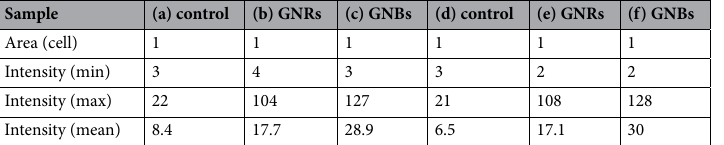
Figure 4 and Fig. S6 illustrate the photos of HepG2 cells cultured with GNBs (LSPR, 760 nm) and GNRs (LSPR, 760 nm) after fs pulsed laser irradiation with the different power. Fig. S7 and S8 show the images of cells co-cultured with GNBs (LSPR, 780 nm) and GNRs (LSPR, 780 nm) after pulsed laser irradiation with different powers. The cell death times for GNBs and GNRs of different sizes under different powers are listed in Table 3 to